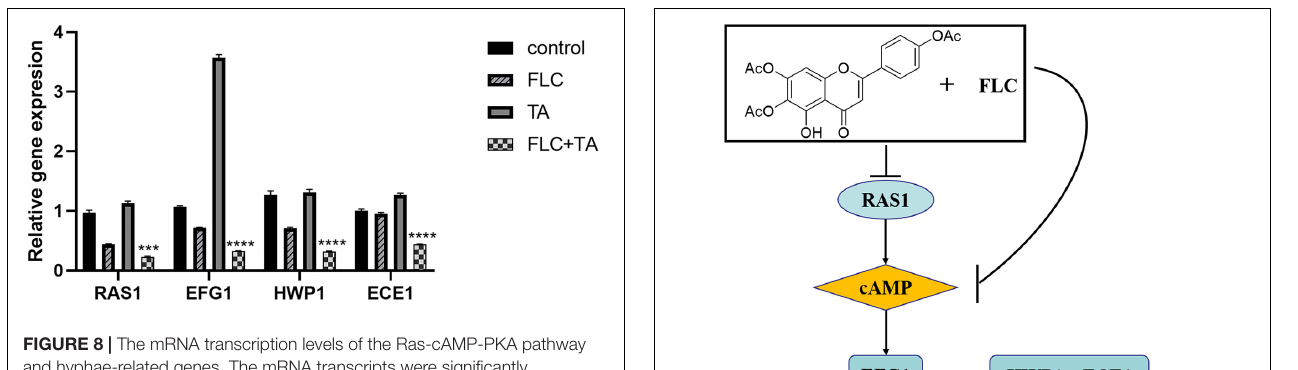
Frontiers in Microbiology |